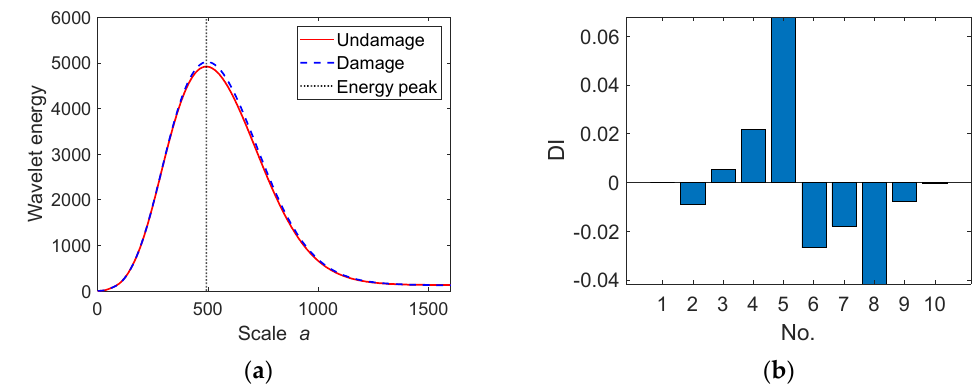
Figure 12. Damage location index.